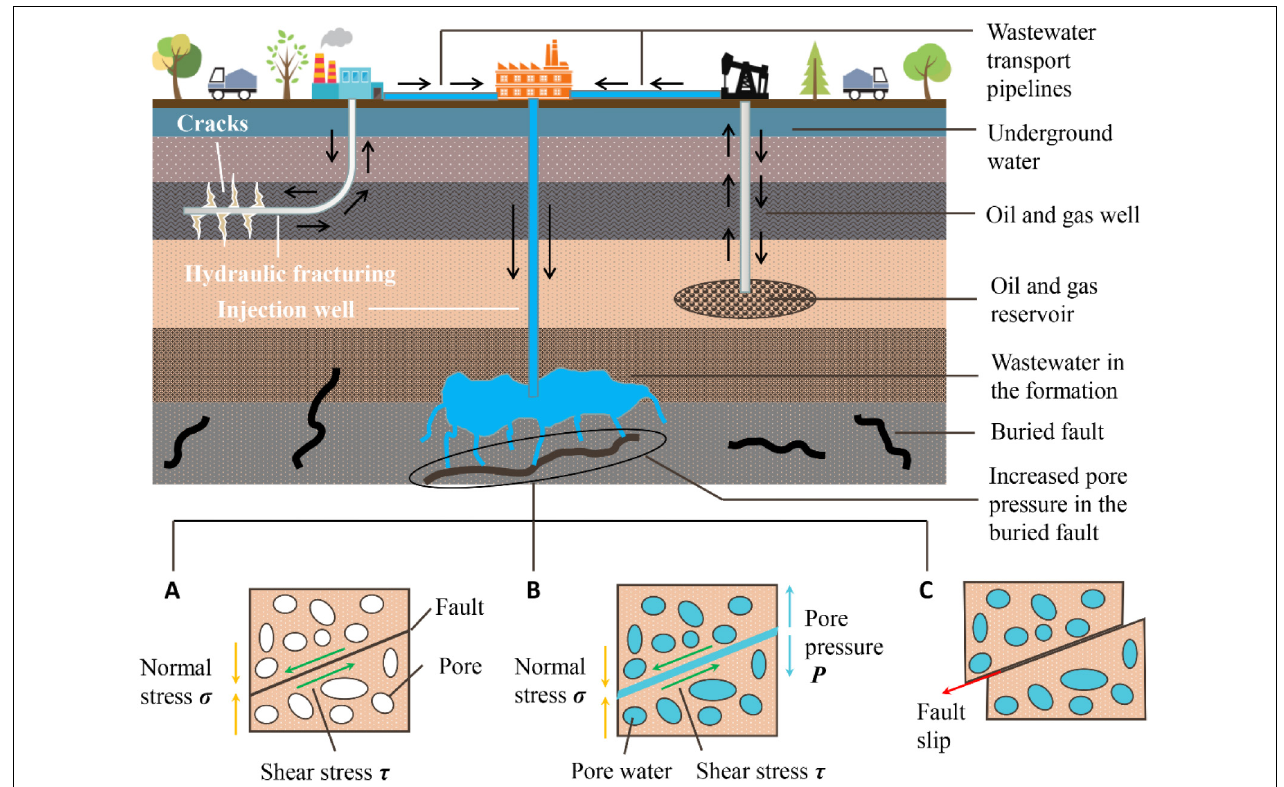
FIGURE 1 | The whole process of fault slip induced by fluid injection in industrial production. (A) Before fluid injection, the fault is closed under the pressure of normal stress on both sides. (B) With the continuous injection of fluid during the production process, the pores and cracks in the fault are gradually filled with fluid. (C) When pore pressure increases to a certain value, the fault slips because the effective normal stress on both sides is less than the shear stress; then, an earthquake is